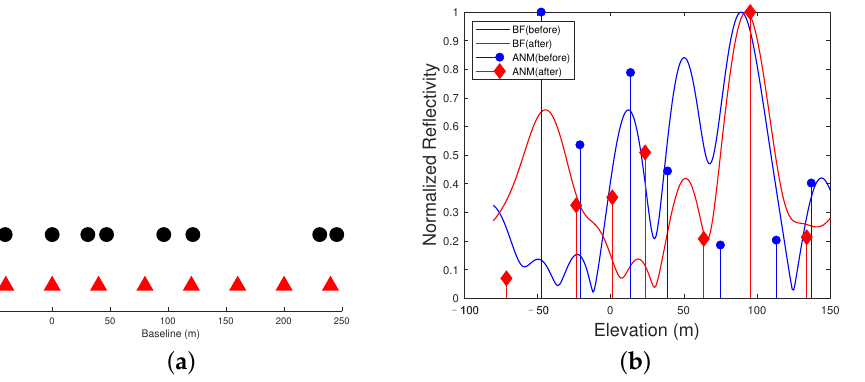
Figure 12. The baseline compensation step. ( a ) Baselines before (black circle) and after (red triangle) baseline compensation. ( b ) The beamforming spectrum and ANM results along elevation before and after baseline